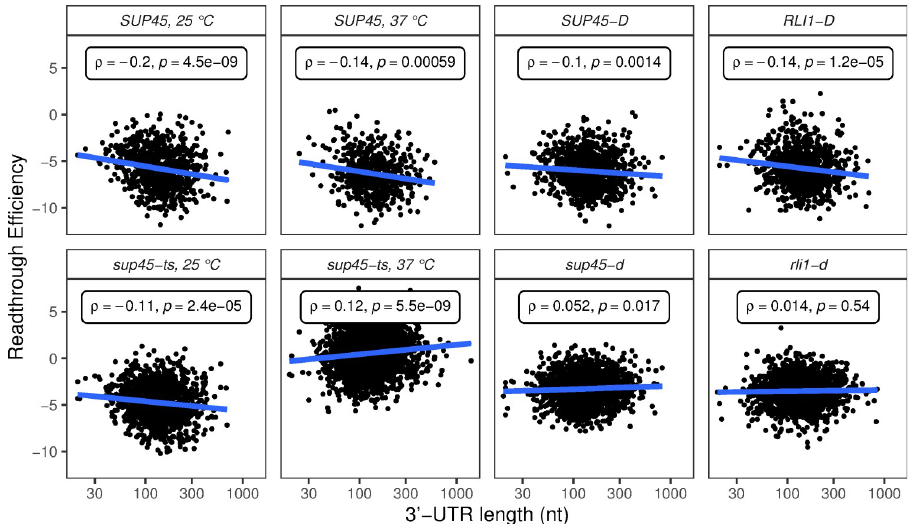
Fig 8. Readthrough efficiency increased with 3’-UTR lengths in eRF1 mutants, but not in wild-type or ribosome recycling factor mutant cells. Scatter plots of readthrough efficiency vs. 3’-UTR length. Spearman’s correlation coefficient ( ρ ) and p-value were calculated for each